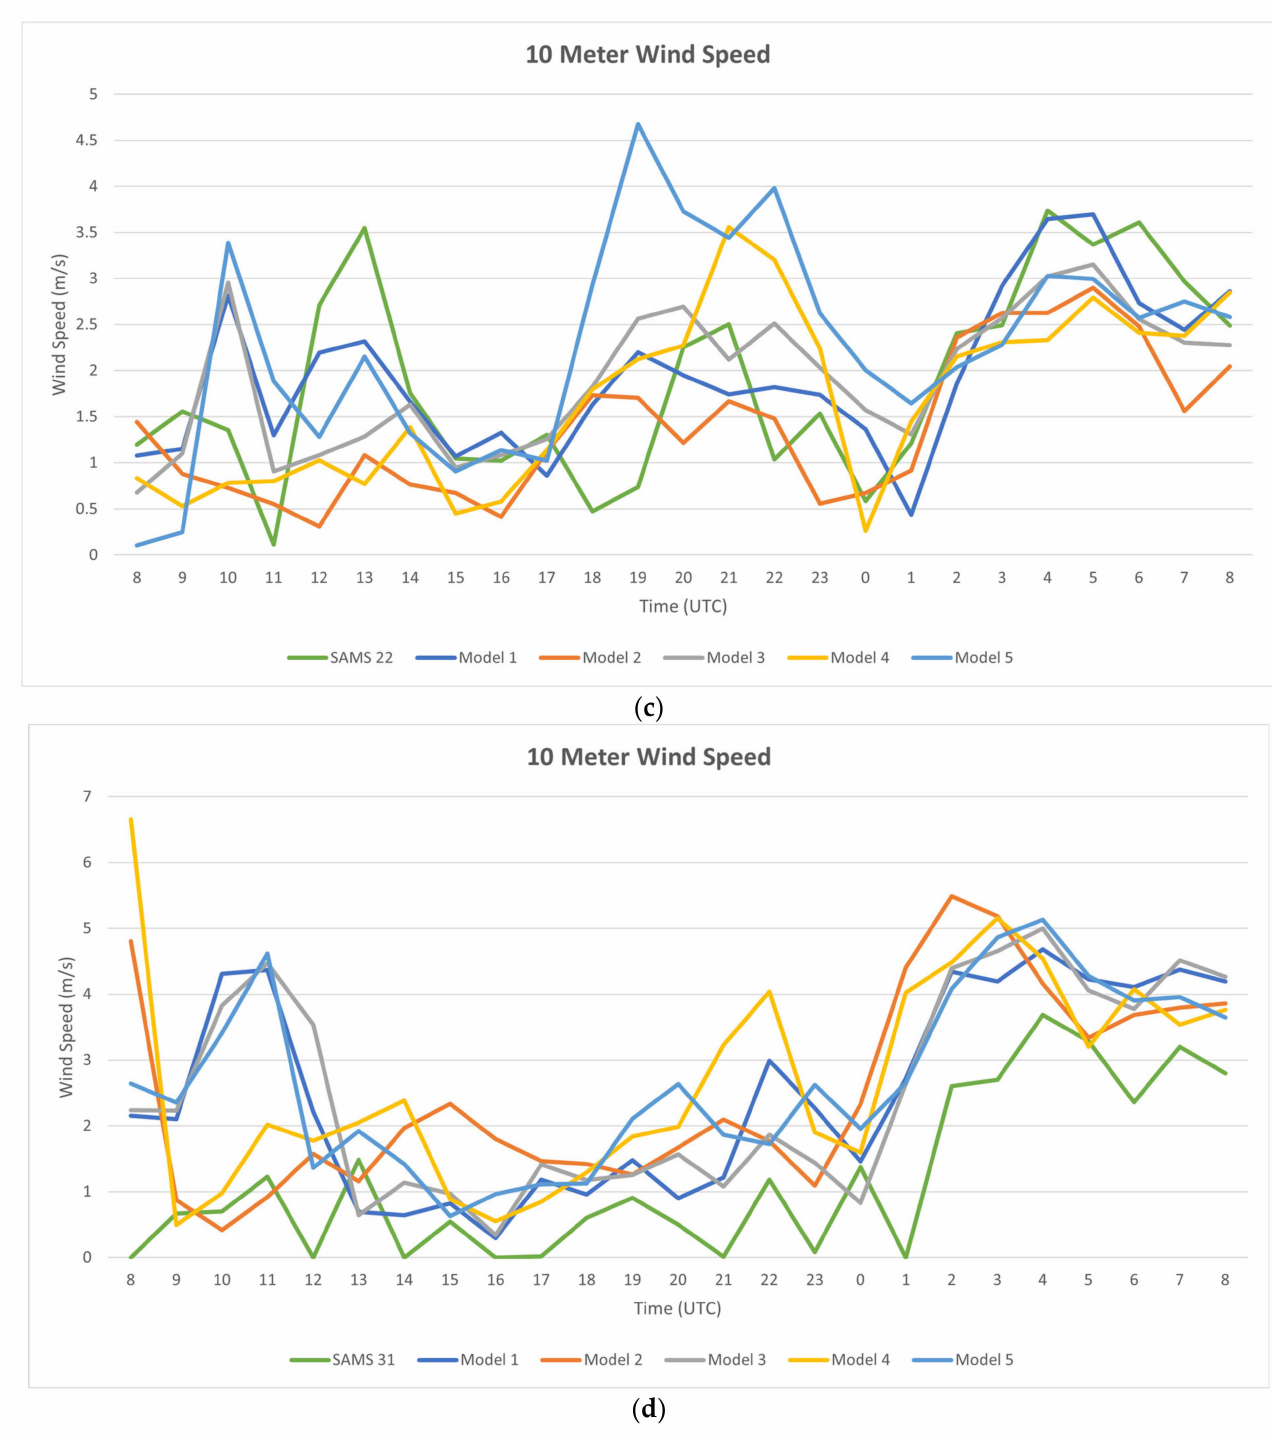
Figure 8. Observed 10 m AGL surface wind speed (m/s) compared with model-simulated 10 m AGL surface wind speed (m/s) for the different experiments across IOP6 at SAMS off-playa ( a ) site 2, ( b ) site 10, ( c ) site 22, ( d ) site 31 as shown in Figure